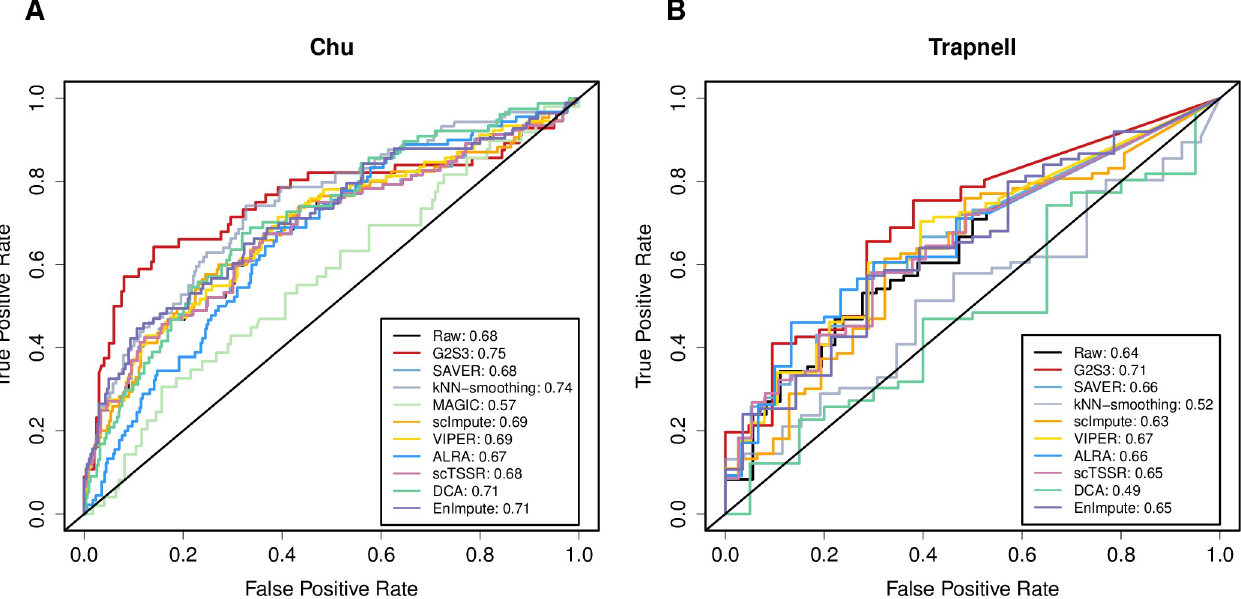
Fig 5. Receiver operating characteristic (ROC) curves demonstrating improvement in differential expression analysis. ROC curves measuring the prediction accuracy in scRNA-seq data on differentially expressed genes identified in bulk RNA-seq data from the same samples in the Chu (A) and Trapnell (B)